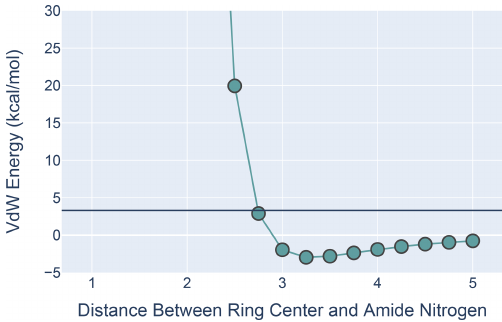
Figure 9. The van der Waals interaction energies for ALA ap- proaching PHE with its amide N-H aligned with the ring normal. On the x axis is the distance from the ALA nitrogen to the PHE ring center. VdW interaction energies for each distance were calcu- lated by subtracting the VdW energies of ALA and PHE in isola- tion from the energies calculated at that distance from one another. All calculations were performed in MoSART using the AMBER99 force